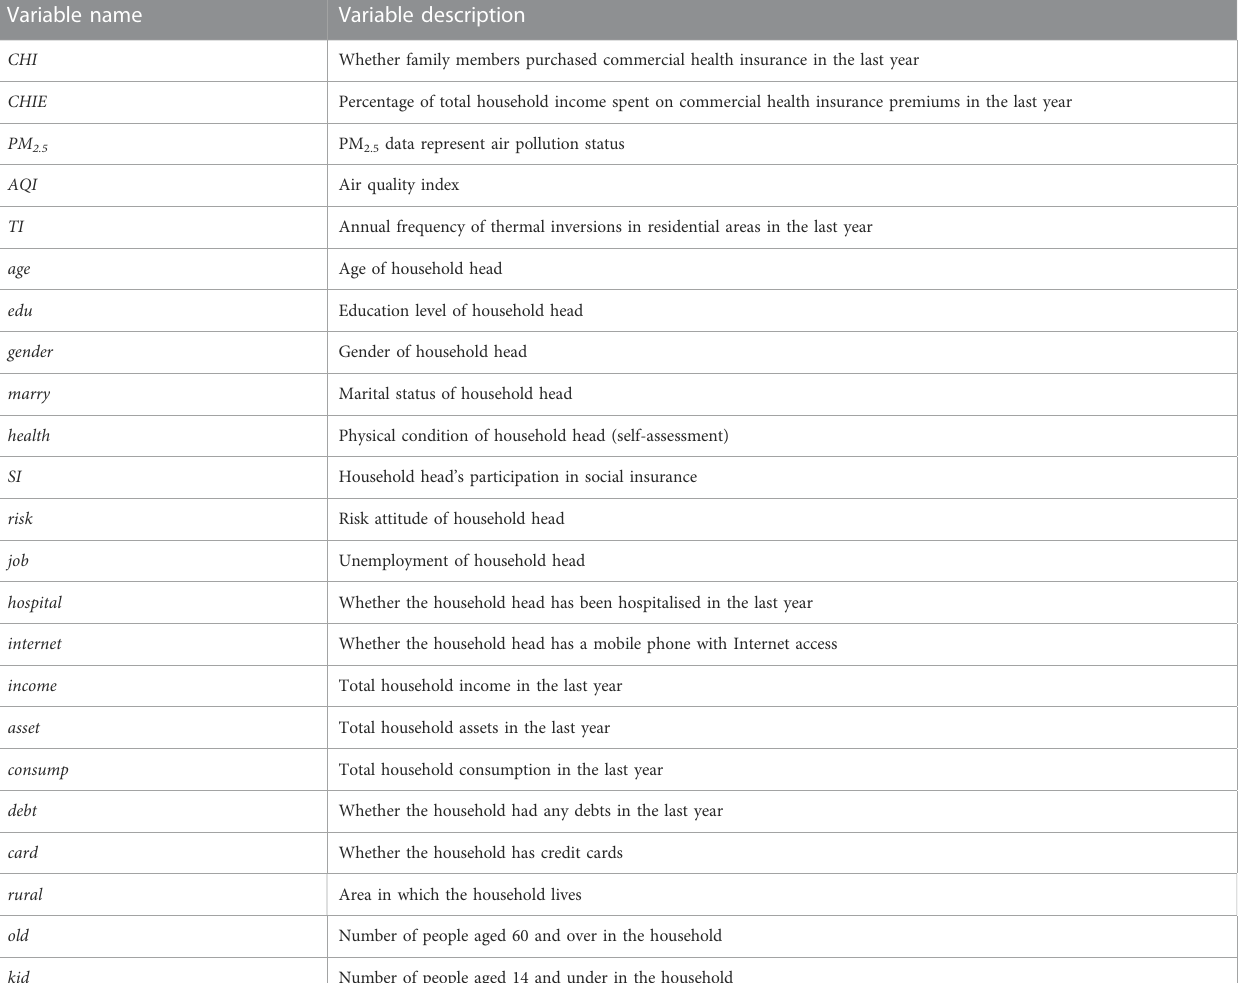
TABLE 1 Variable de fi